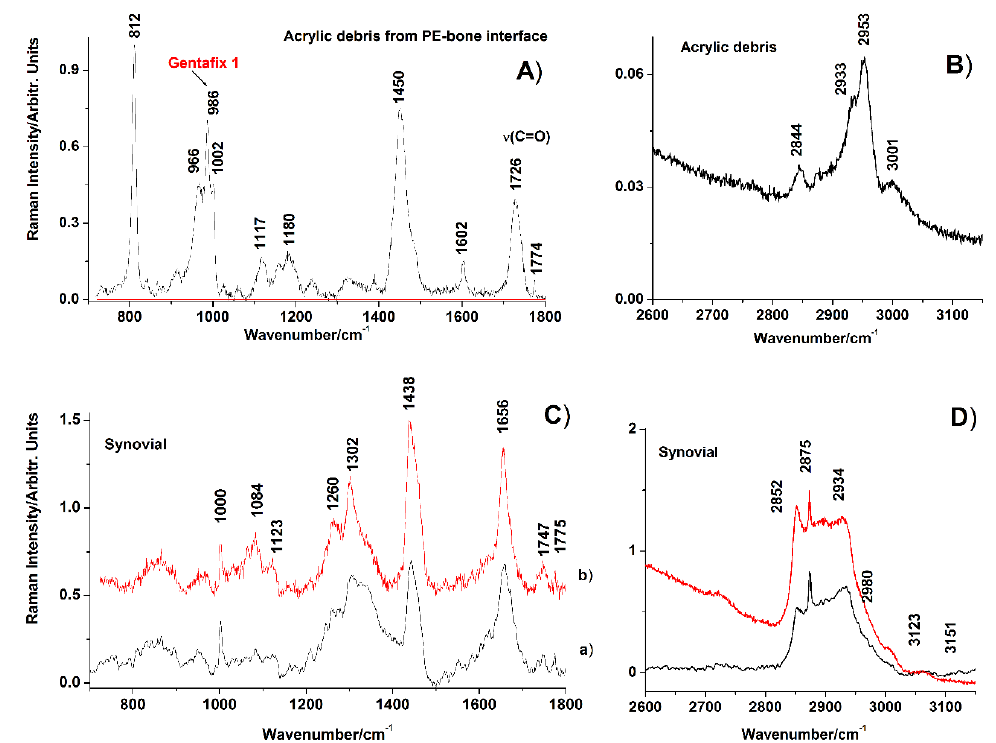
Figure 7. Micro-Raman spectra collected in the low ( A ) and high wavenumber range ( B ) from the surface of acrylic cement debris detached from the metallic stem, characteristic for acrylic-bone interface; and ( C , D ) synovial fluid spectra from light (a) and dark (b) spotted points, accumulated in the stem of the tibial component. Averaged spectra of 10 distinct points acquisitions are given; spectra were background subtracted and normalized to unit; Excitation: 785 nm, 30 mW.